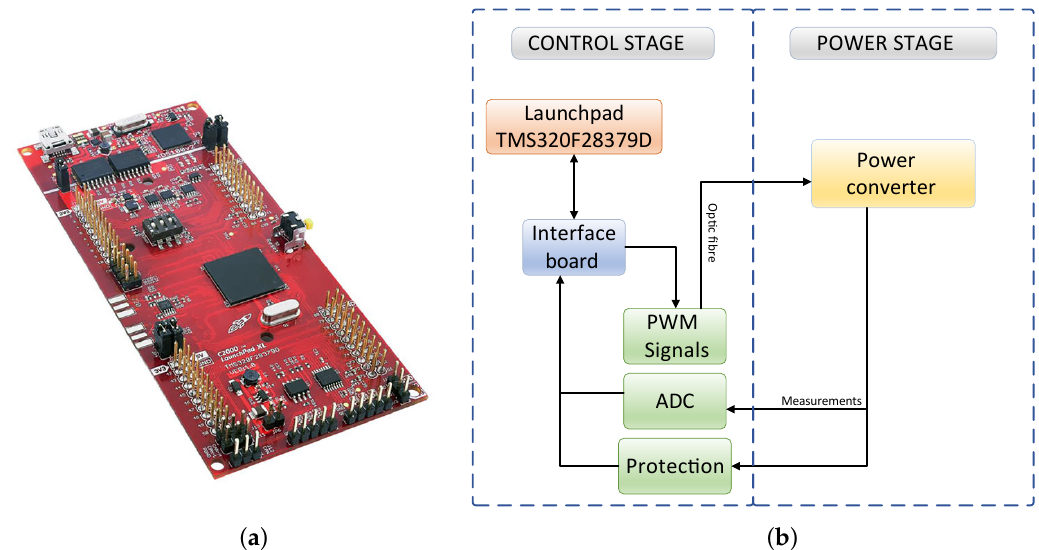
Figure 1. ( a ) Launchpad TMS320F28379D. ( b ) Overview of the proposed RTCP.